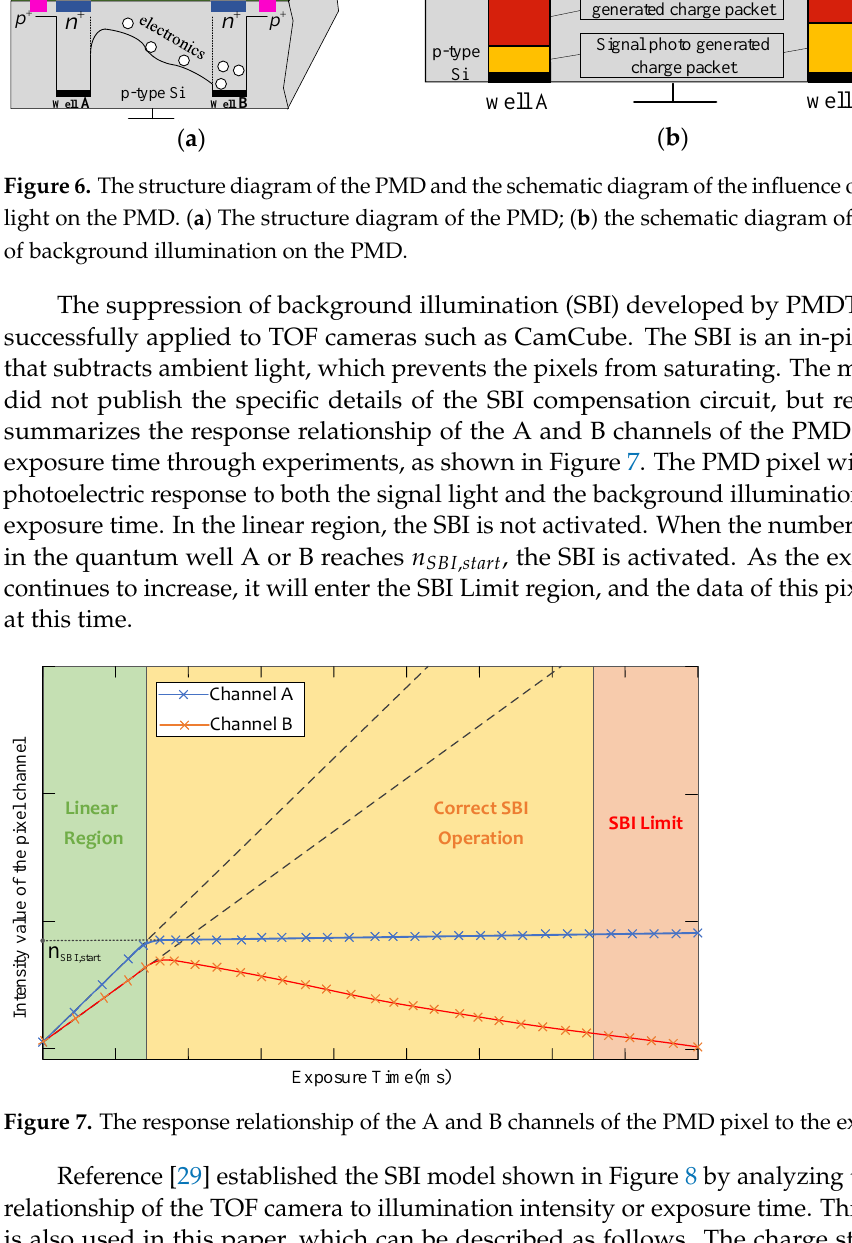
Figure 7. The response relationship of the A and B channels of the PMD pixel to the exposure time.